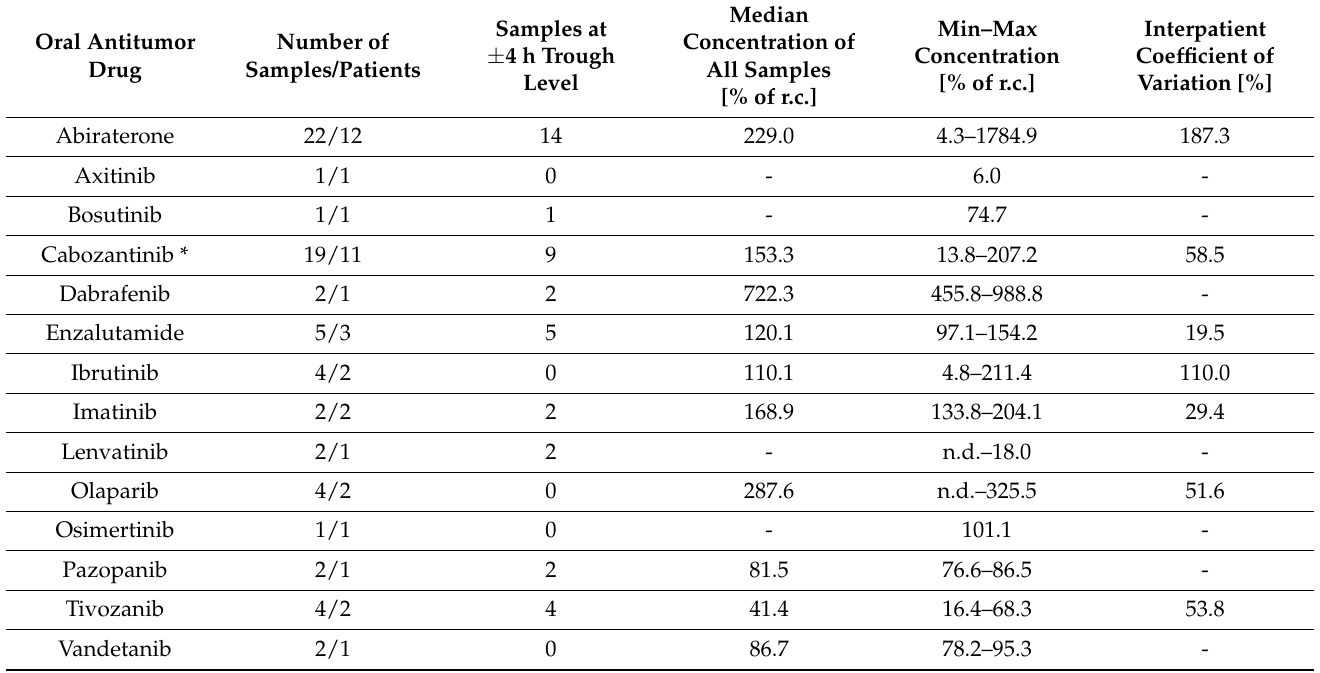
Table 1. Summary of results from 71 plasma samples of patients treated with an oral anticancer drug.